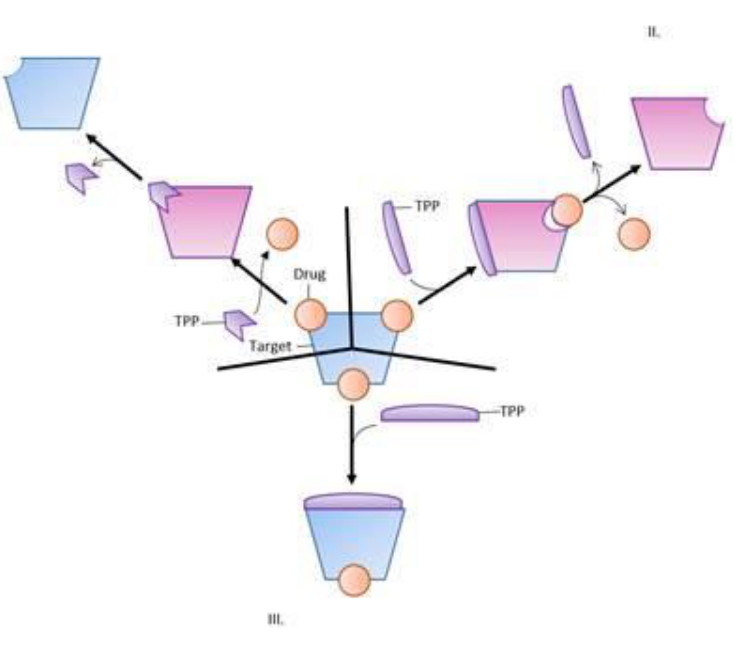
Figure 4. Types of antimicrobial target protection mechanisms. ( I ) The target protection protein (TPP) directly displaces the antimicrobial agent from its active site on the target, preventing antimicrobial action. ( II ) The target protection protein binds an allosteric site of the target, which induces a conformation change and the dissociation of the antimicrobial agent from the target site. ( III ) The target protection protein induces a global conformational change to reestablish target function despite the formation of a target-drug complex [84]. This figure kindly provided courtesy of Ann F. Varela.